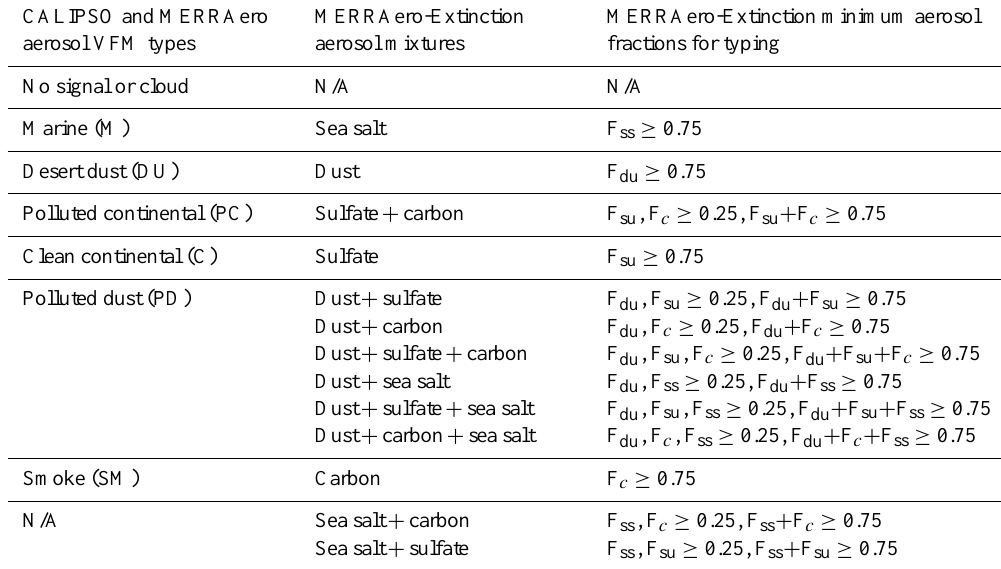
Table 2. Mapping of MERRAero aerosol mixtures to CALIOP VFM